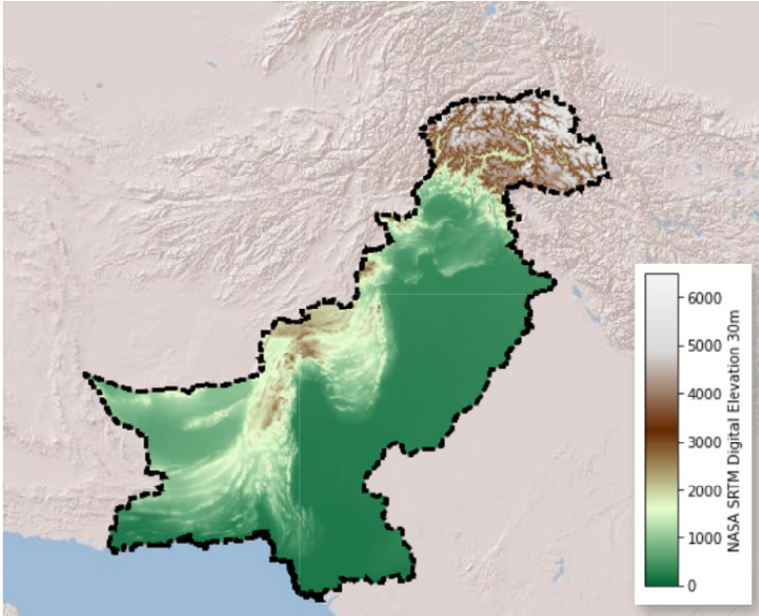
Figure 3. Elevation of the study area.